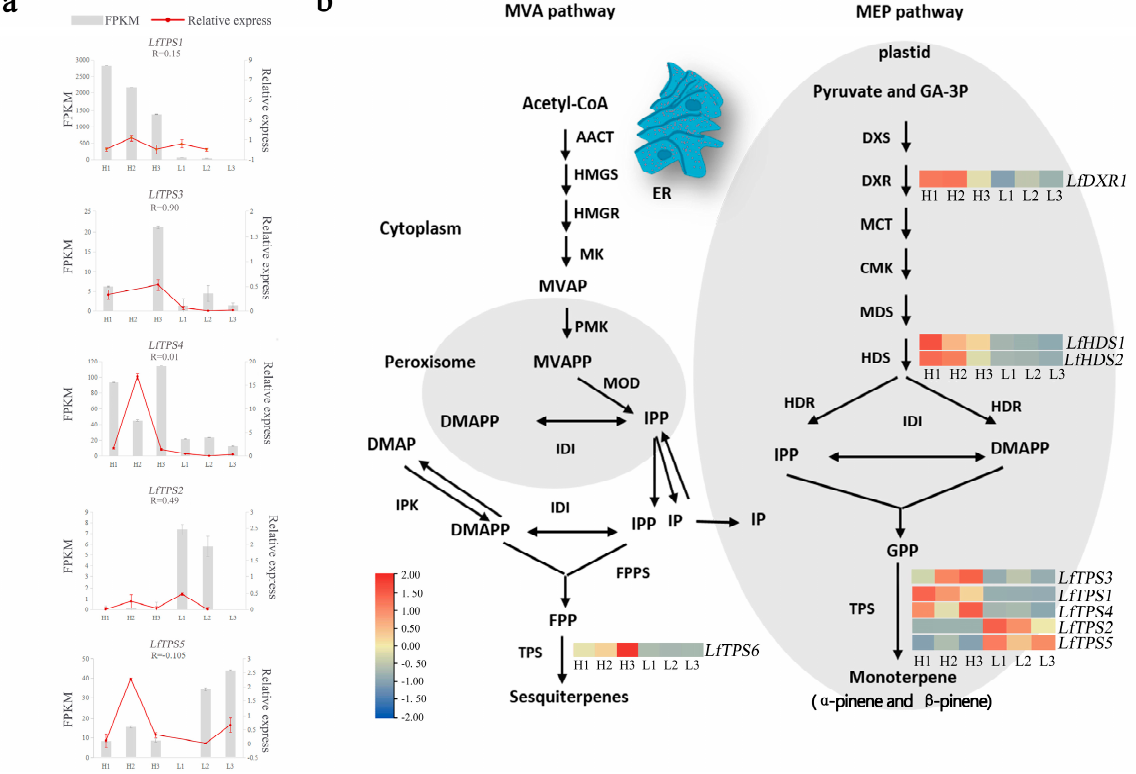
Figure 4. Identification of genes related to monoterpene biosynthesis. ( a ) Fragments per kilobase of exon per million reads (FPKM) and quantitative real-time polymerase chain reaction (qRT-PCR). Error bars represent the standard error (SE). “R” meaned the correlation coefficient between FPKM and relative express. ( b ) Differentially expressed genes related to terpenoid biosynthesis. Expres- sion profiles of genes encoding enzymes involved in the terpenoid backbone biosynthesis pathway (ko00900) and monoterpenoid biosynthesis pathway (ko00902) (group H vs. group L). Enzymes related to terpenoid biosynthesis are shown in red frames. The expression pattern was shown within six columns: the 3 columns on the left represent the H group and the 3 columns on the right represent the L group. AACT, acetyl-CoA C-acetyltransferase; HMGS, hydroxymethylglutaryl-CoA synthase; HMGR, hydroxymethylglutaryl-CoA reductase; MK, mevalonate kinase; PMK, phosphomeval- onate kinase; MDC, mevalonate diphosphate decarboxylase; DXS, 1-deoxy-D-xylulose-5-phosphate synthase; DXR, 1-deoxy-D-xylulose-5-phosphate reductoisomerase; MCT, 2-C-methyl-D-erythritol 4-phosphate cytidylyltransferase; CMK, 4-diphosphocytidyl-2-C-methyl-D-erythritol kinase; MDS, 2-C-methyl-D-erythritol 2,4-cyclodiphosphate synthase; HDS, (E)-4-hydroxy-3-methylbut-2-eny-l- diphosphate synthase; HDR, 4-hydroxy-3-methylbut-2-en-1-yl diphosphate